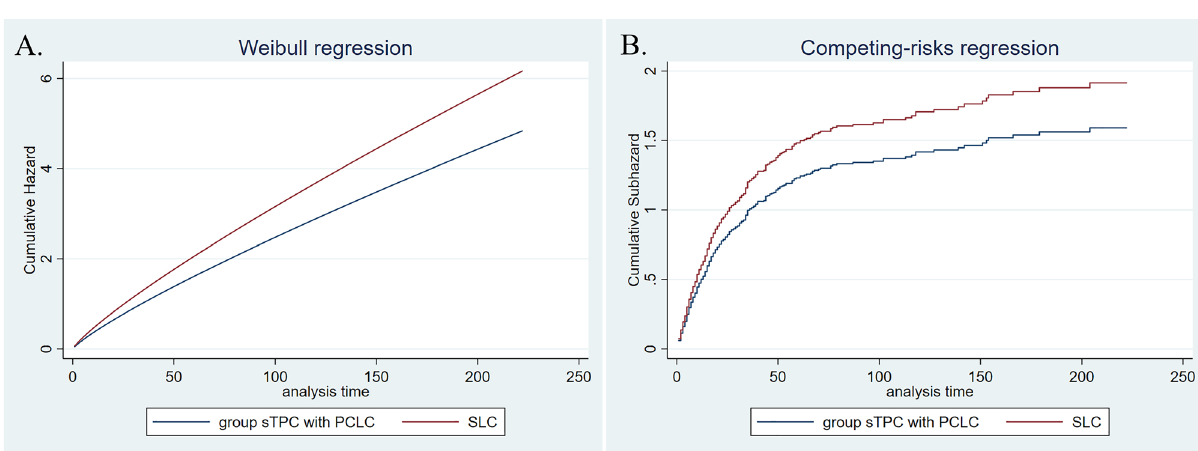
Figure 1. Adjusted cumulative hazard of all-cause death ( A ) and cancer-specific death ( B ) in PCLC and matched single lung cancer.